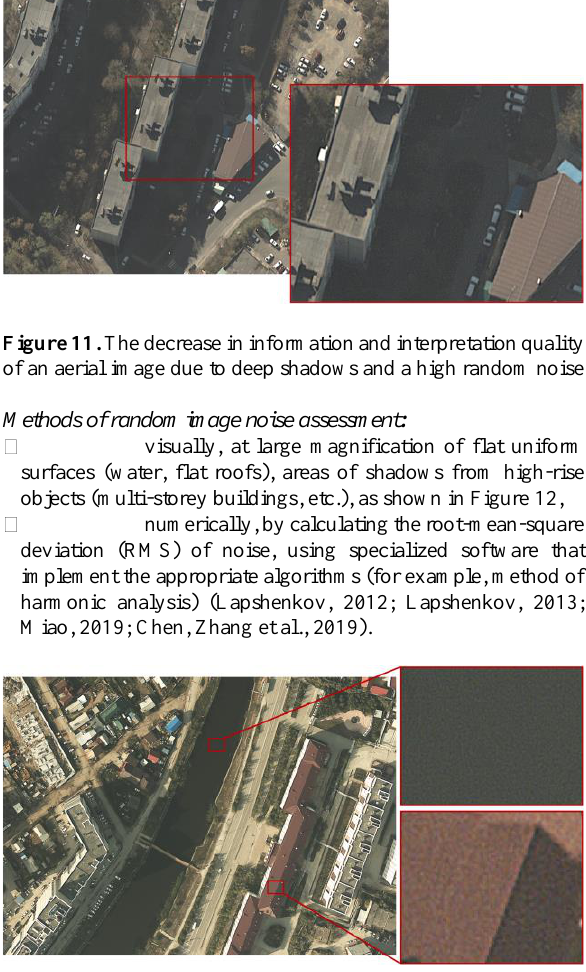
Figure 12. Random image noise, noticeable at high magnification on the water area and on the roof surface The method of harmonic analysis proposed by Lapshenkov (2012, 2013) has proven itself well for assessing the random image noise level. This method allows to determine the random noise RMS ( Nrms ) in digital image with high accuracy.